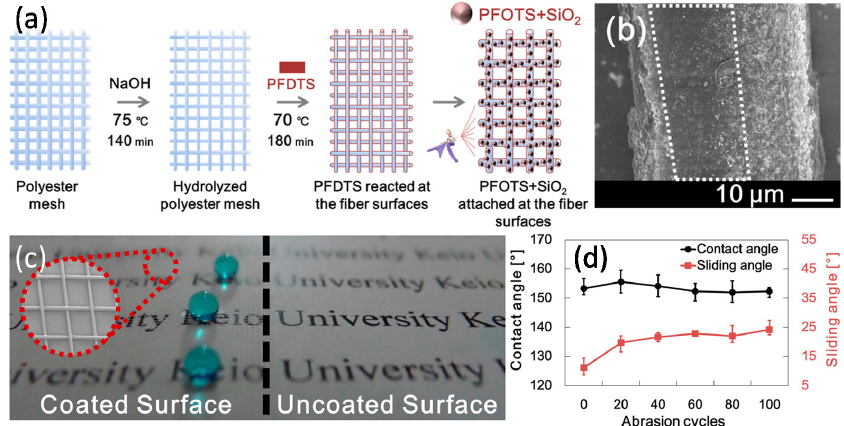
Figure 11. ( a ) Schematic of the fabrication procedure for the superhydrophobic polyester mesh.